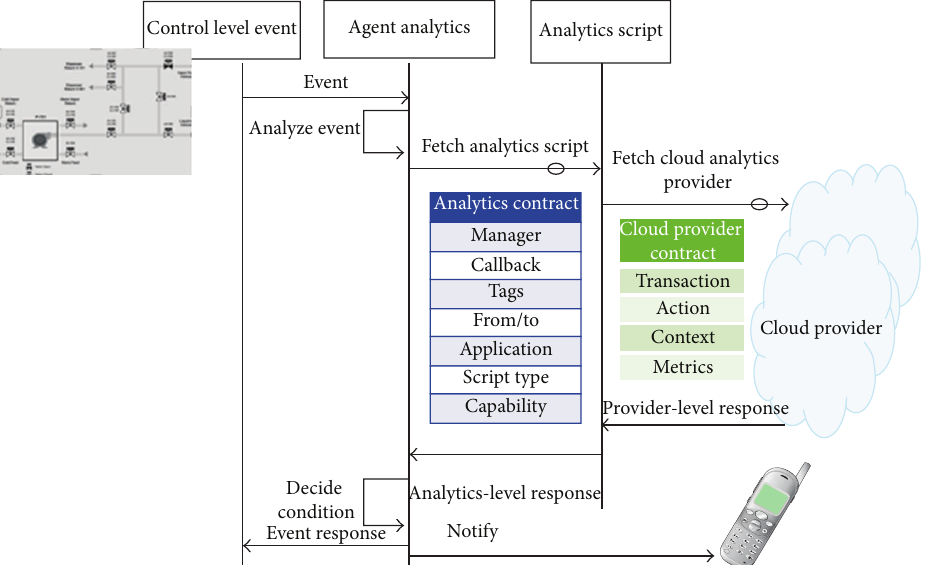
Figure 4: Design and programming